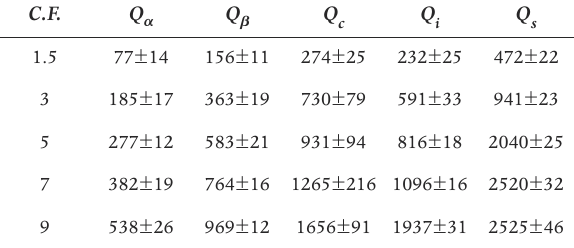
, Q and Q values as a func- a b c